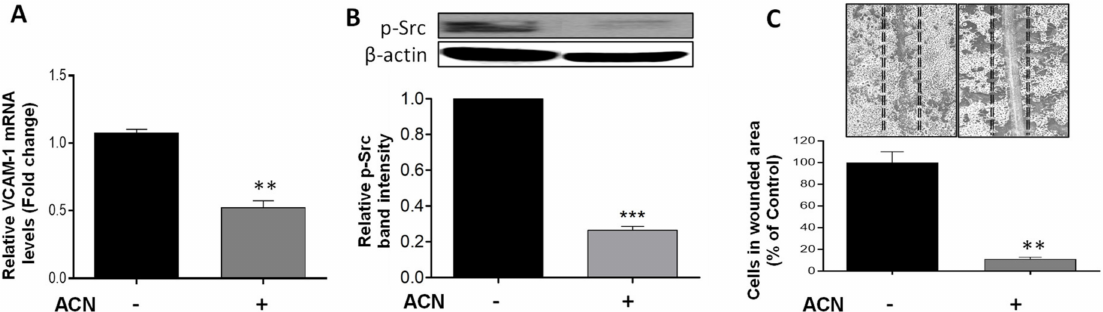
Figure 5. ACN downregulated VCAM-1 and p-Src involved in BC invasion and suppressed wound healing in 4T1 cells. VCAM-1 mRNA levels ( A ). The VCAM-1 mRNA levels were determined after 24 h treatment with or without ACN (IC 50 ) as detailed in materials and methods. Protein levels of p-Src ( B ). Protein levels of target proteins were determined after 48 h ACN treatment in cell lysates by immunoblot analysis with primary and secondary antibodies as detailed in materials and methods. Western blots are representative of at least two independent experiments (upper panel). Band intensities of p-Src determined with ImageJ software were divided by band intensity of β -actin, and values were normalized to untreated control (lower panel). ACN-mediated suppression of wound healing ( C ). Quantification of wound healing was performed by counting the number of cells in scratched area after 48 h treatment with ACN (IC 50 ) using ImageJ software. Data from mRNA are mean ± SEM ( n = 3). Data from relative band intensity determined with ImageJ software are mean ± SEM. Data from wound healing assay are mean ( n ≥ 4) ± SEM. The unpaired t test with Welch’s correction was used to determine significance (*** p < 0.001, ** p <